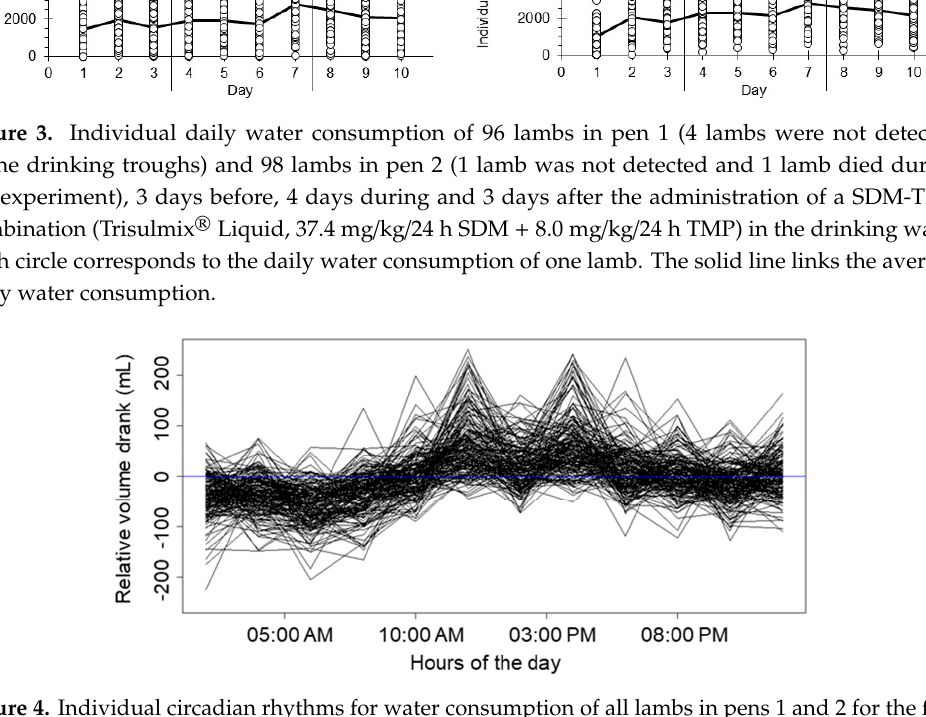
Figure 4. Individual circadian rhythms for water consumption of all lambs in pens 1 and 2 for the first field experiment. field